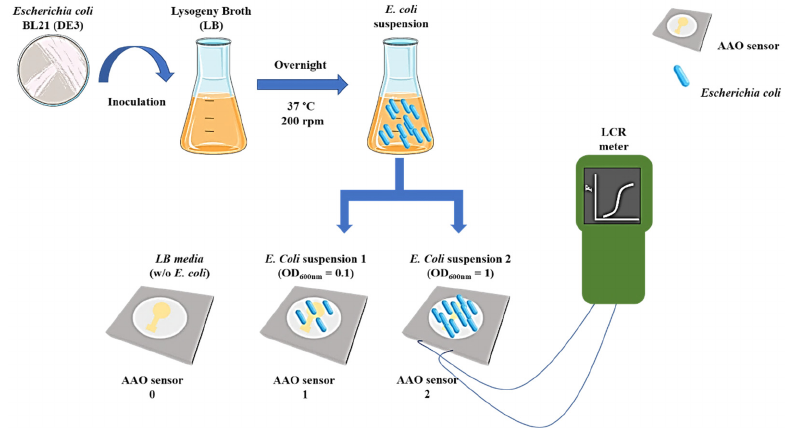
Figure 4. Schematic representation of the experimental sequence for the bacterial touch sensing tests.